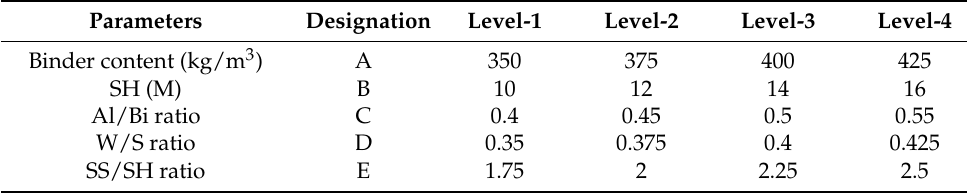
Table 2. Parameters and levels used in the Taguchi experiment design.